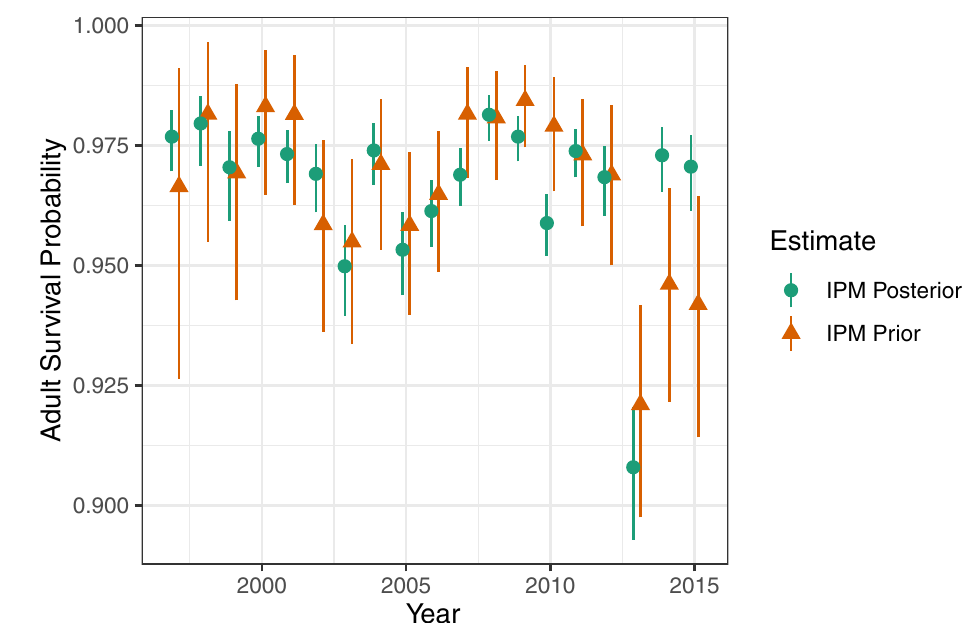
Figure 7. Estimated adult survival probabilities by year. The estimated IPM prior is from the photo- identification analysis of manatees in southwest Florida 11, 52 . The estimated IPM posterior integrates those estimates with carcass recoveries and other data. Symbols indicate medians; line segments indicate 95% credible intervals.